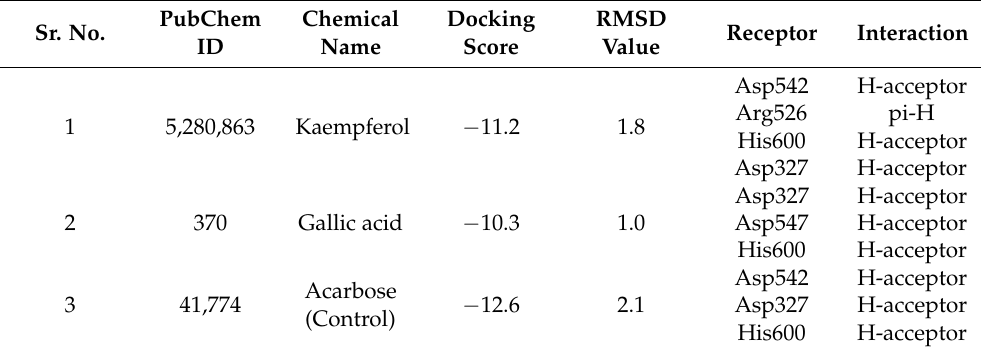
Table 2. Interaction detail of top two bioactive phytochemicals and control in the proposed site of α